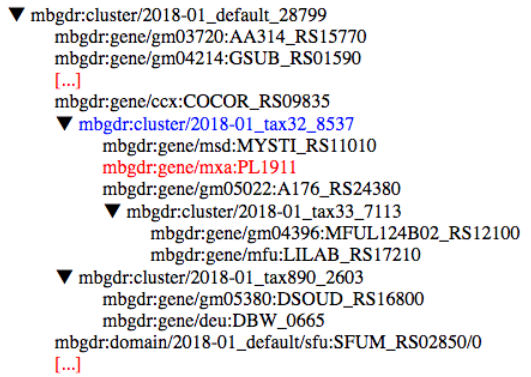
Figure 2. A fragment of the hierarchical orthologous cluster no. 28799 in MBGD. A cluster can consist of genes, domains (sub-genes) or further nested orthologous clusters. Multiple levels of the hierarchy may need to be traversed recursively in order to reach a given orthologous gene. For example, the gene mxa: PL1911 (highlighted in red) can be reached through the member orthologous cluster 2018-01_tax32_8537 (shown in blue). This can be achieved in SPARQL through a recursive graph pattern, using the hasHomologous* property path 1 - a graphical abstraction of the RDF representation is provided in Figure